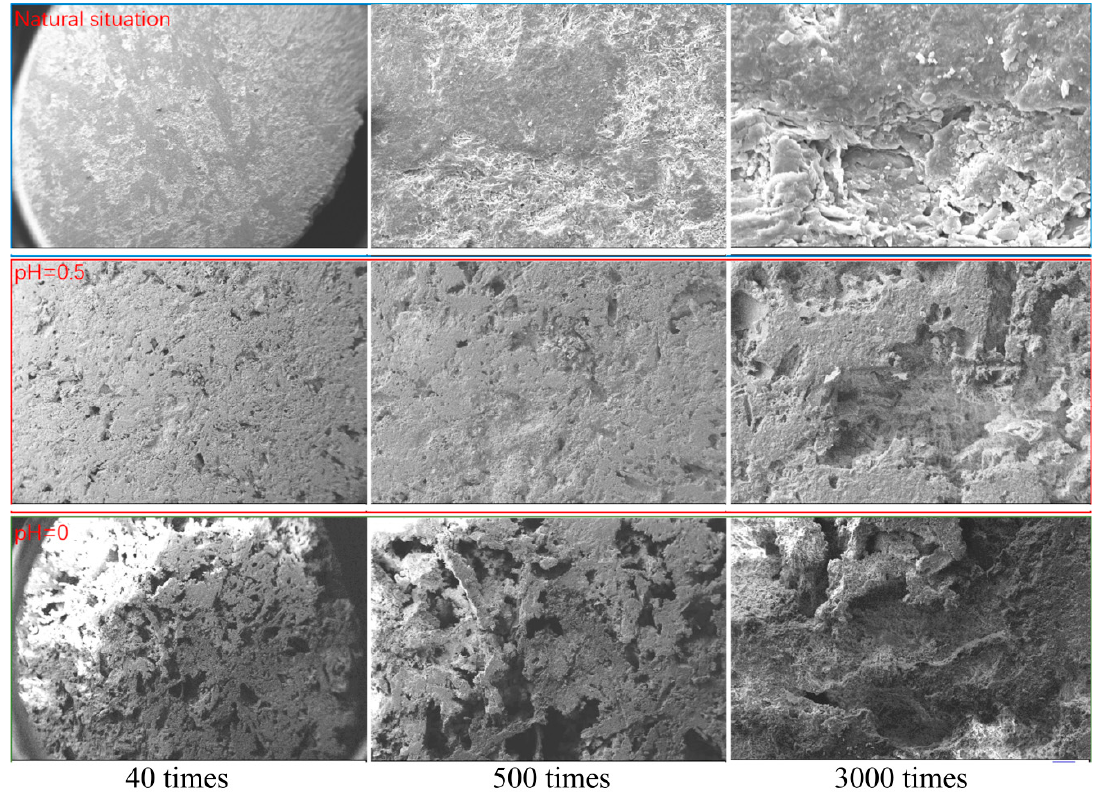
Figure 8. Microstructure characteristics of samples under different acid etching conditions.